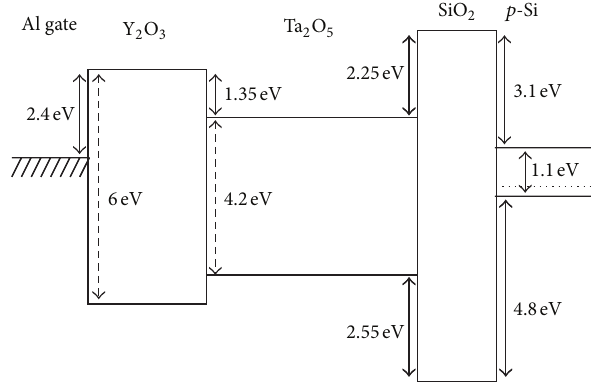
Figure 1: Schematic energy band diagrams of the Al/Y 2 O 3 /Ta 2 O 5 / SiO 2 /Si memory device.